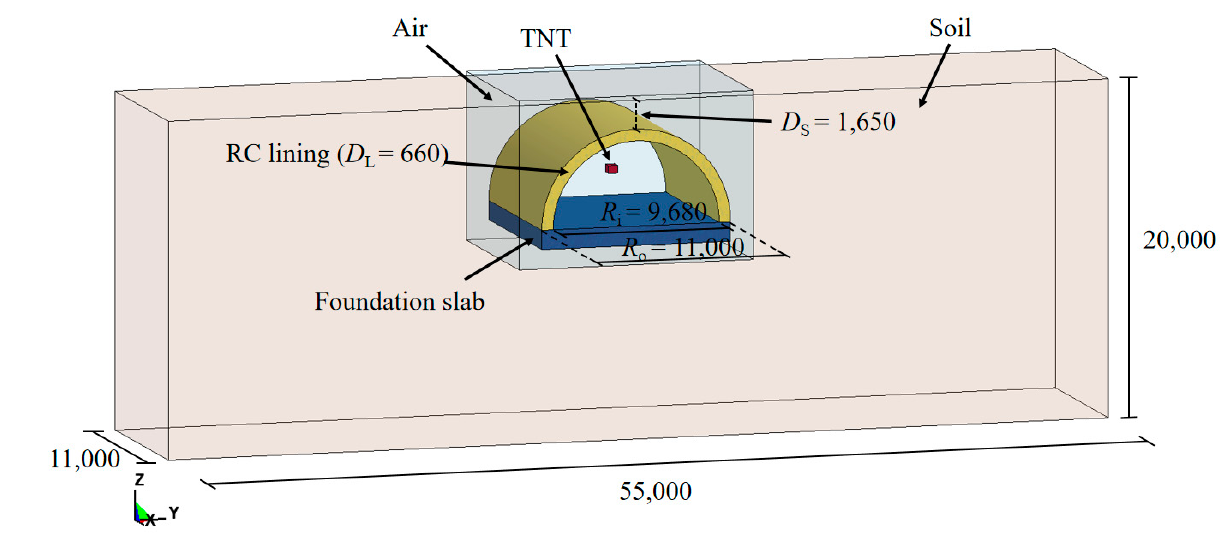
Figure 10. FE model of the prototype of tunnel entrance (unit: mm).